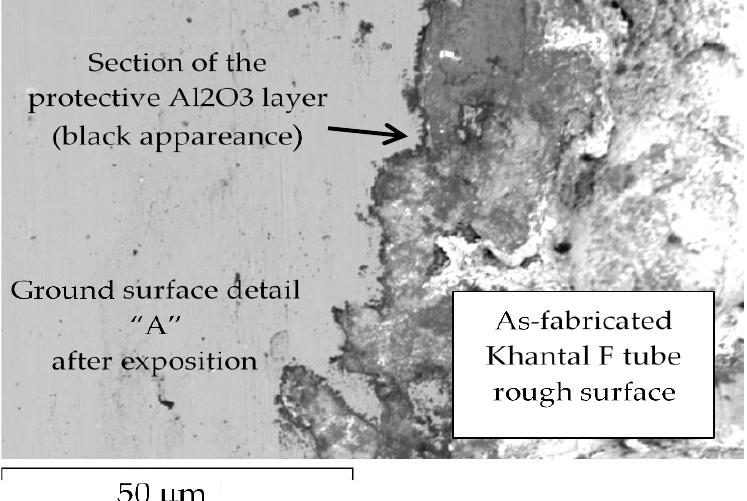
Figure 3. Kanthal F thermocouple tubing ground on a side after exposure to liquid lead for 1000 h at T = 850 °C. The as-fabricated Khantal F tube had a rough surface due to the hot-extrusion manu- facturing process (Figure 3a) and it was necessary to grind one side of the surface in order to have a better and smooth surface for any corrosion-evidence study (Figures 3a and 4).